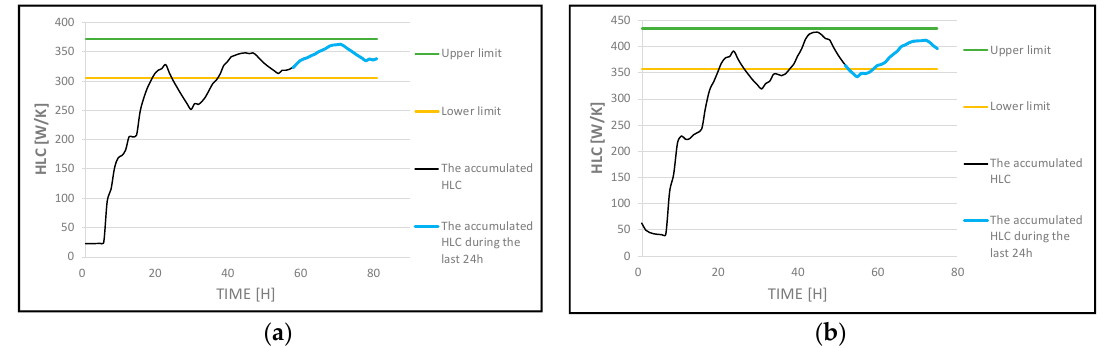
Figure A2. Evolution of the accumulated average of the Heat Loss Coefficient for ( a ) period 1 and ( b ) period 2 in Loughborough.